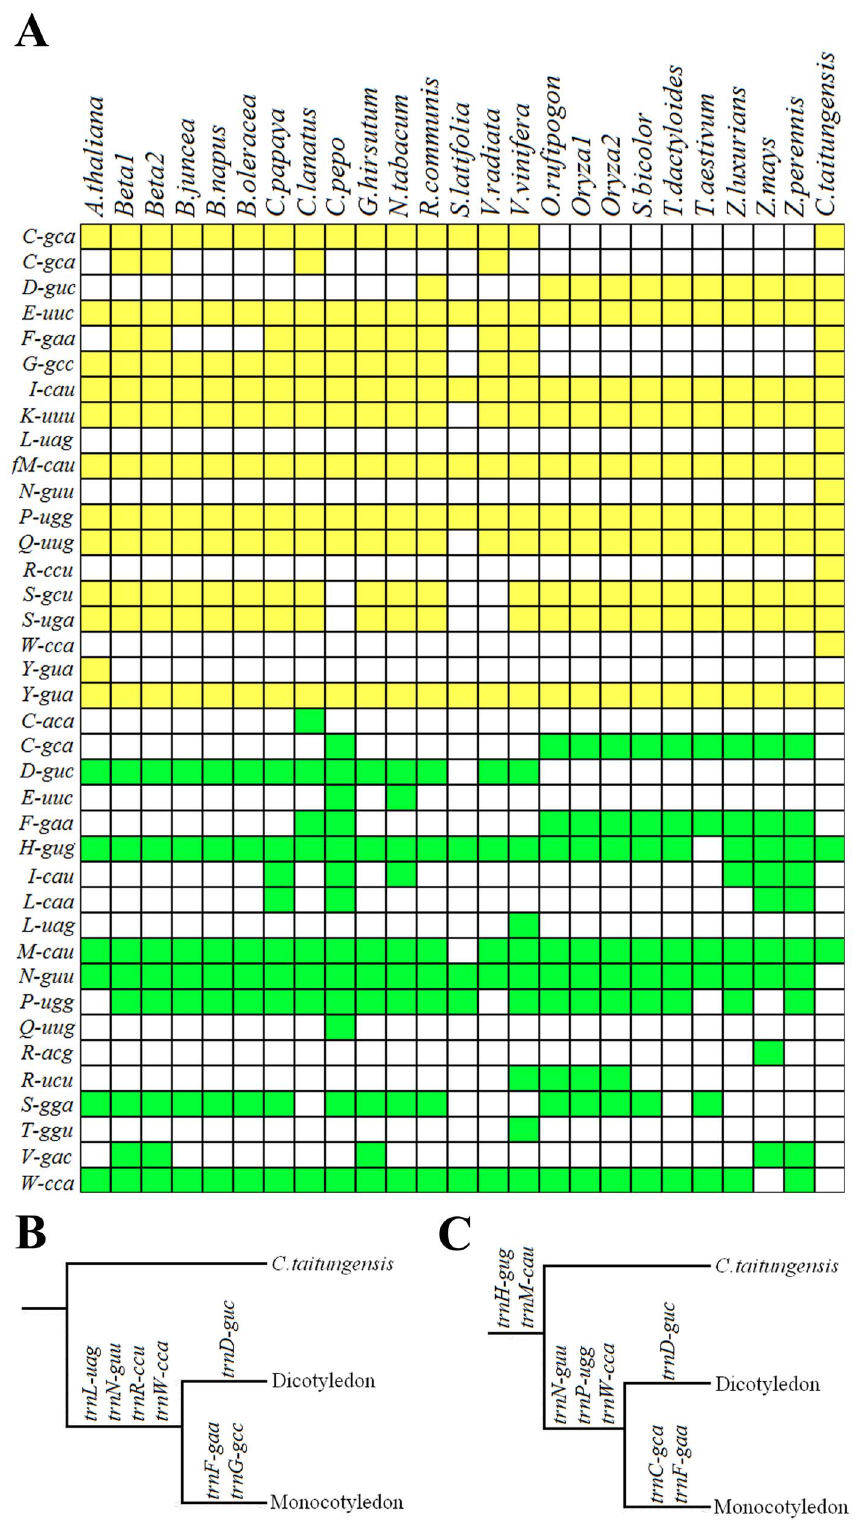
Figure 5. Distribution map of tRNA genes in 25 plants. Figure 5A shows distribution of tRNA genes in higher plant mt genomes: the yellow boxs represented native tRNA genes, the green cells represent cp-like tRNA genes; Figure B shows uptake of cp-like tRNA genes during different evolutionary period; Figure C shows loss of native tRNA genes during different evolutionary period. The three Oryza genomes: 1, Oryza rufipogon ; 2, Oryza sativa subsp indica ; 3, Oryza sativa subsp japonica . The two Beta genomes are: 1, Beta vulgaris subsp maritima ; 2, Beta vulgaris subsp vulgaris .